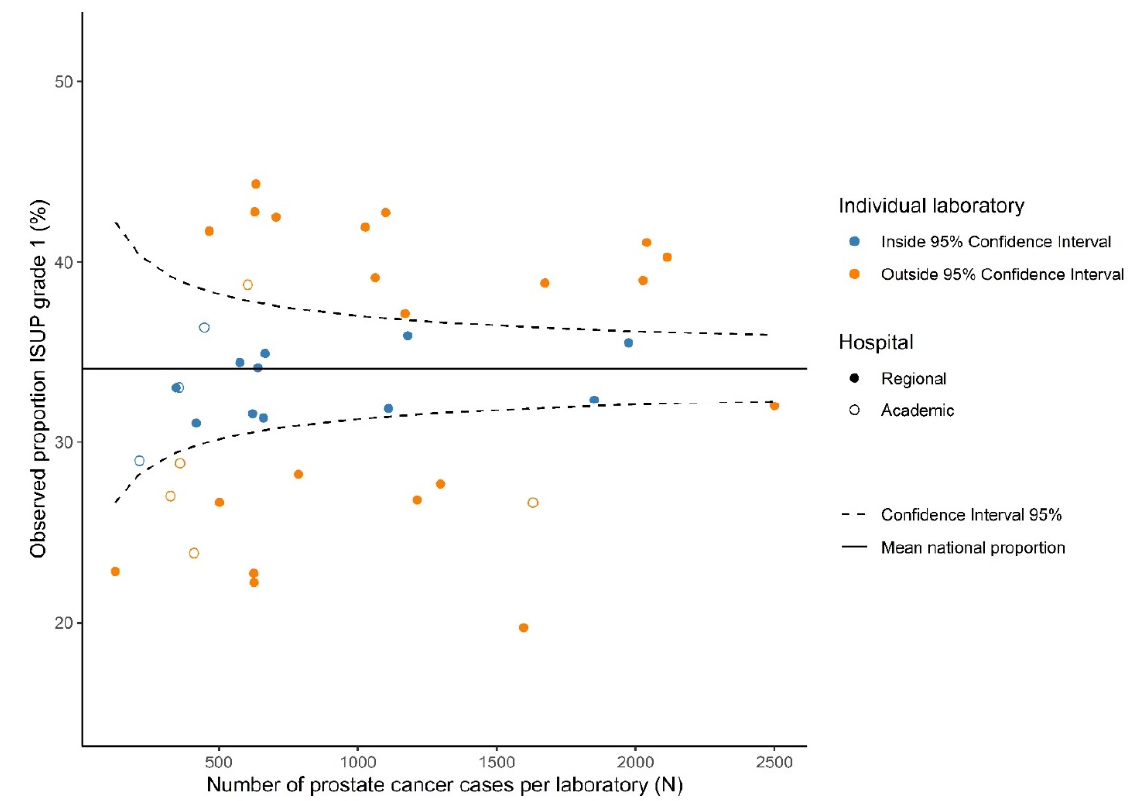
Figure 1. Funnel plot showing the observed proportion for ISUP Grade 1 prostate cancer grade per laboratory (dots) relative to the mean national proportion and its 95% confidence intervals.